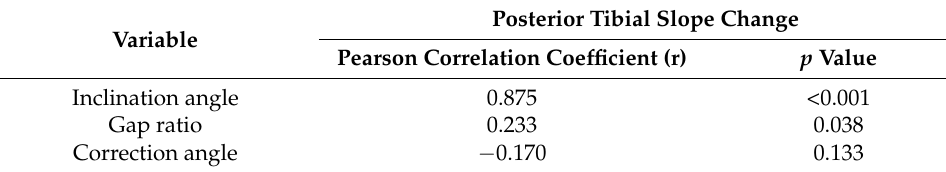
Figure 5. Scatter plot of Pearson correlation analysis showing the correlation between sagittal osteotomy inclination angle and the posterior tibial slope change. The sagittal osteotomy inclination angle has a significantly positive correlation with the posterior tibial slope change (r = 0.875, p < 0.001). Table 5. Correlation between variables and change in posterior tibial slope.